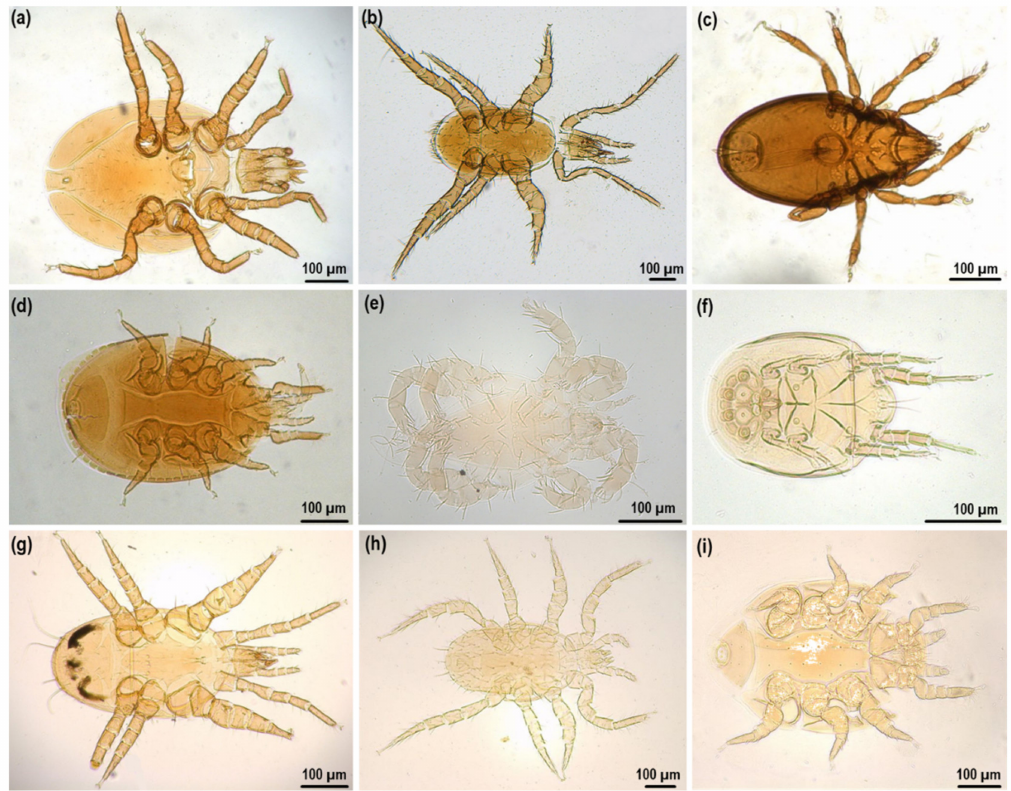
Figure 2. Phoretic mites from Ips spp. in Turkey ( a ) Pleuronectocelaeno barbara. ( b ) Schizostethus simulatrix. ( c ) Paraleius cf. leontonychus. ( d ) Trichouropoda lamellose. ( e ) Ereynetes sp. ( f ) Histiostoma piceae. ( g ) Dendrolaelaps quadrisetus. ( h ) Proctolaelaps hystricoides. ( i ) Uroobovella